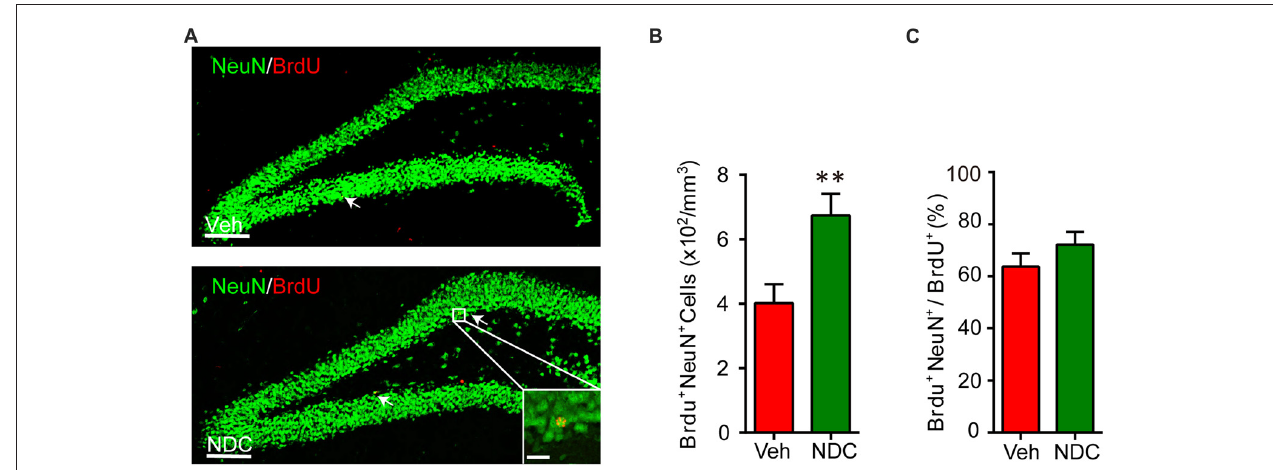
FIGURE 7 | NDC enhances neurogenesis in APP/PS1 mice. (A) NeuN (green) and BrdU (red) staining in dentate gyrus (DG) of brain sections from mice treated with vehicle (A) and NDC (B) . (B) Quantification of BrdU + NeuN + cells in the brain sections of vehicle- and NDC-treated mice. (C) Proportion of BrdU + NeuN + cells in all BrdU + cells. Data are presented as mean ± SEM, Veh group n = 7, NDC group: n = 8, ∗∗ p < 0.01, analyzed by two-tailed t -test (B,C) compared with APP/PS1 vehicle group. Scale bars in (A) , 100 µ m; insets, 20 µ